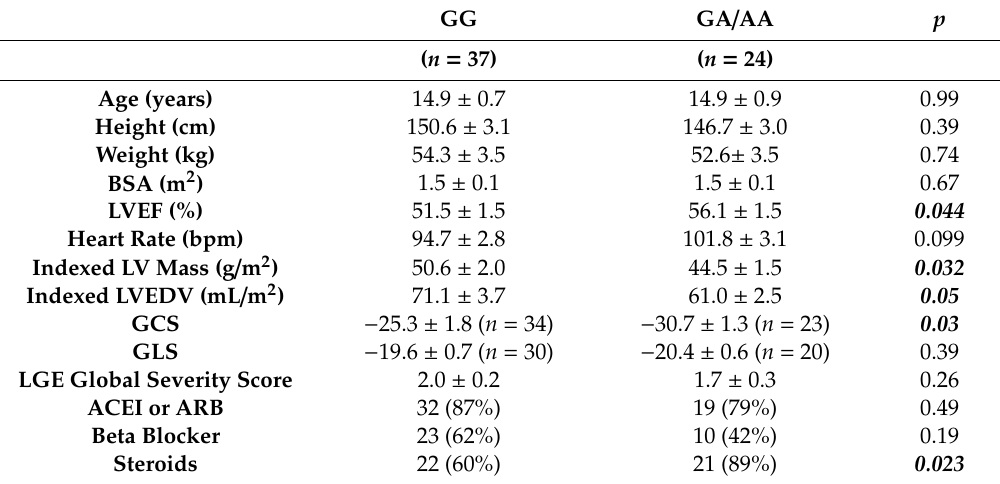
Table 1. Demographics by genotype. Late gadolinium enhancement (LGE) global severity score is ranked from zero (no LGE) to four (extensive involvement of septum and free wall). Group means compared with unpaired t-test for continuous variables or Mann–Whitney rank sum for non-parametric variables. Abbreviations: BSA: Body surface area, LVEF: Left ventricular ejection fraction, LVEDV: Left ventricular end diastolic volume, GCS: Global circumferential strain, GLS: Global longitudinal strain, ACEI: Angiotensin converting enzyme inhibitor, ARB: Angiotensin receptor